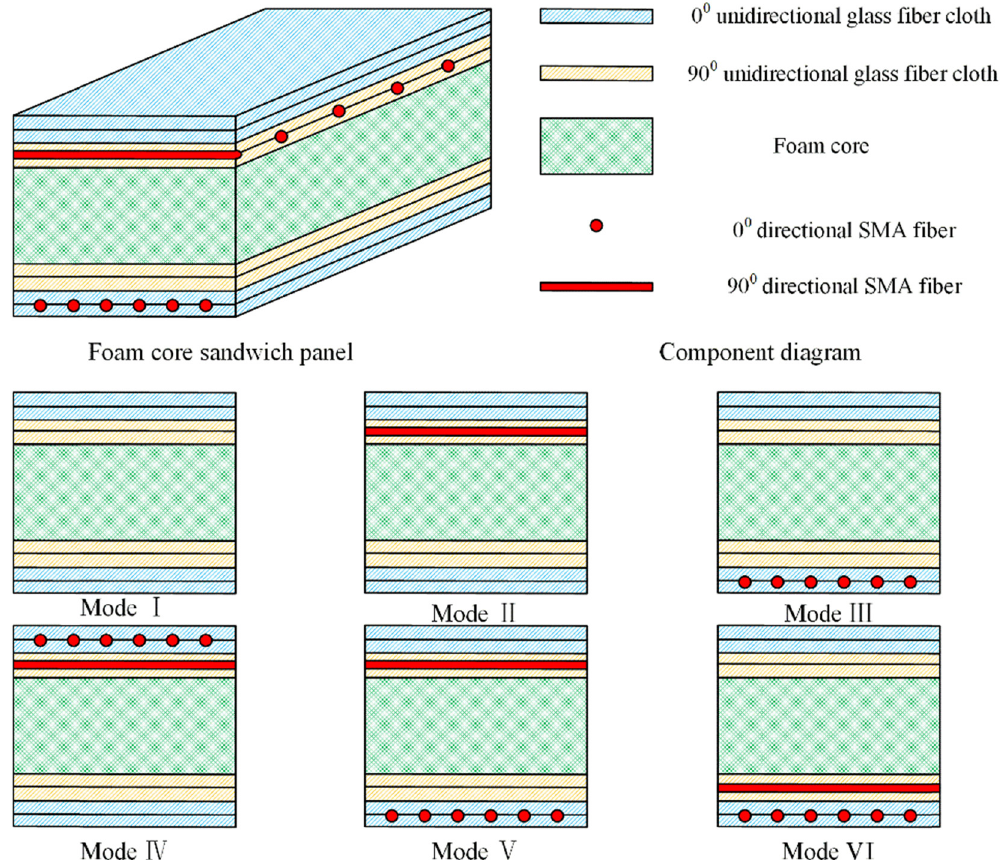
Figure 1: Ply modes of foam core sandwich